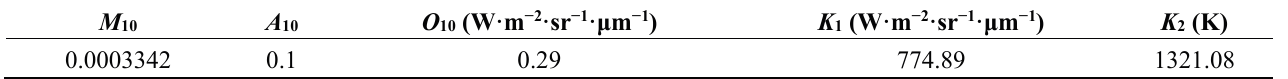
Table 2. Constants for computing brightness temperature from Landsat 8 TIRS Band 10 data.